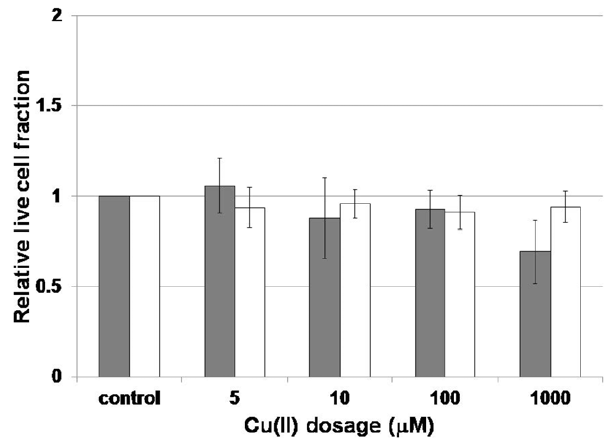
Figure 4. Impact of Cu(II) exposure on membrane integrity in stationary and exponential phase N. europaea cultures. Error bars depict cell counts from ten replicate fluorescence images.